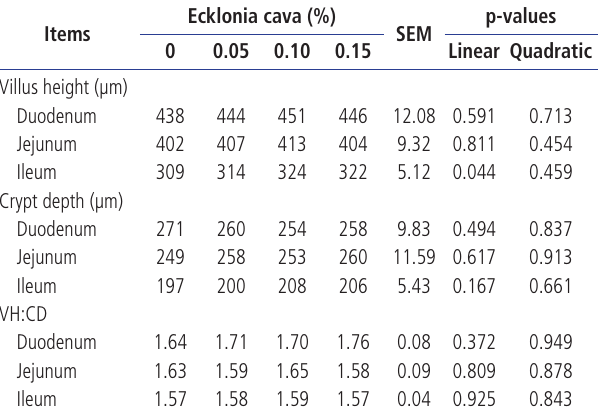
Table 7. Effects of supplemental Ecklonia cava on small intestinal morphology of weanling pigs (d 28) Ecklonia cava (%) Items